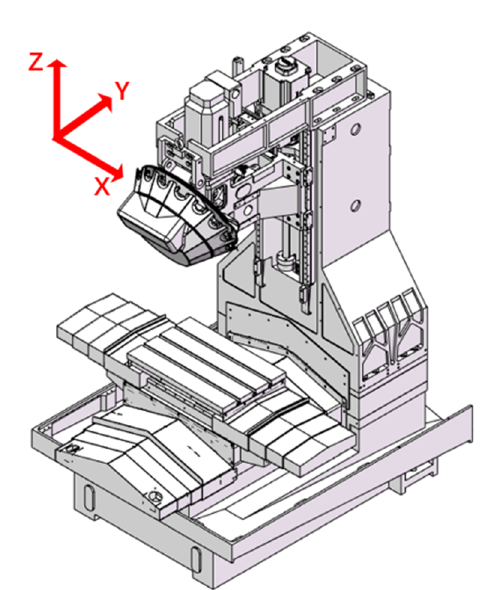
Figure 1. Three-axis drilling machine.